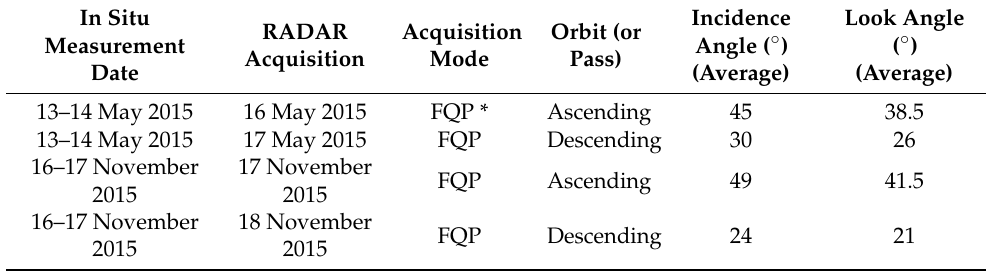
Table 1. Radar characteristics of RADARSAT-2 fine quad-mode polarization images of the study